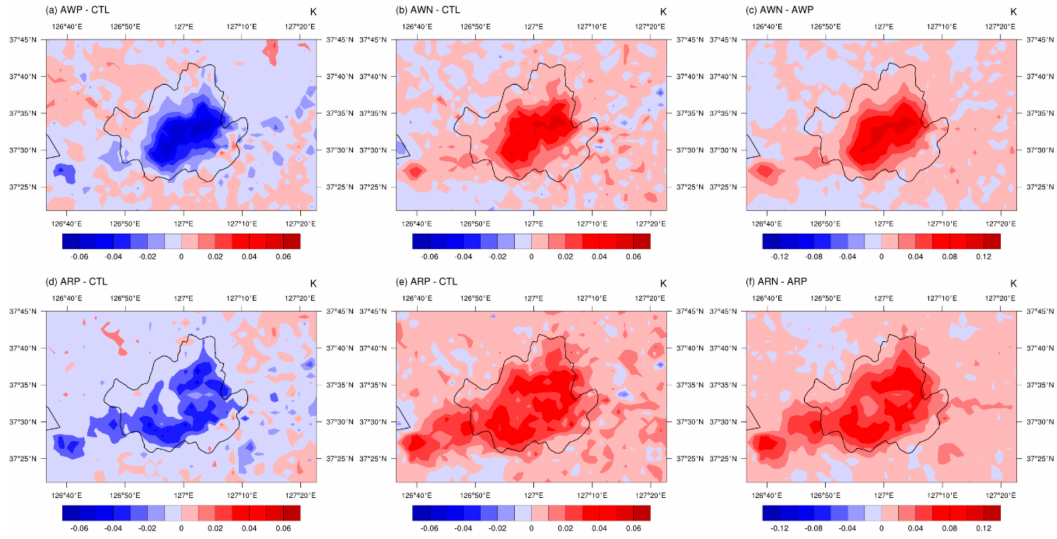
Figure 8. Distribution of mean 1.5-m temperature in ( a ) AWP-CTL, ( b ) AWN-CTL, ( c ) AWN-AWP, ( d ) ARP-CTL, ( e ) ARN-CTL, ( f )